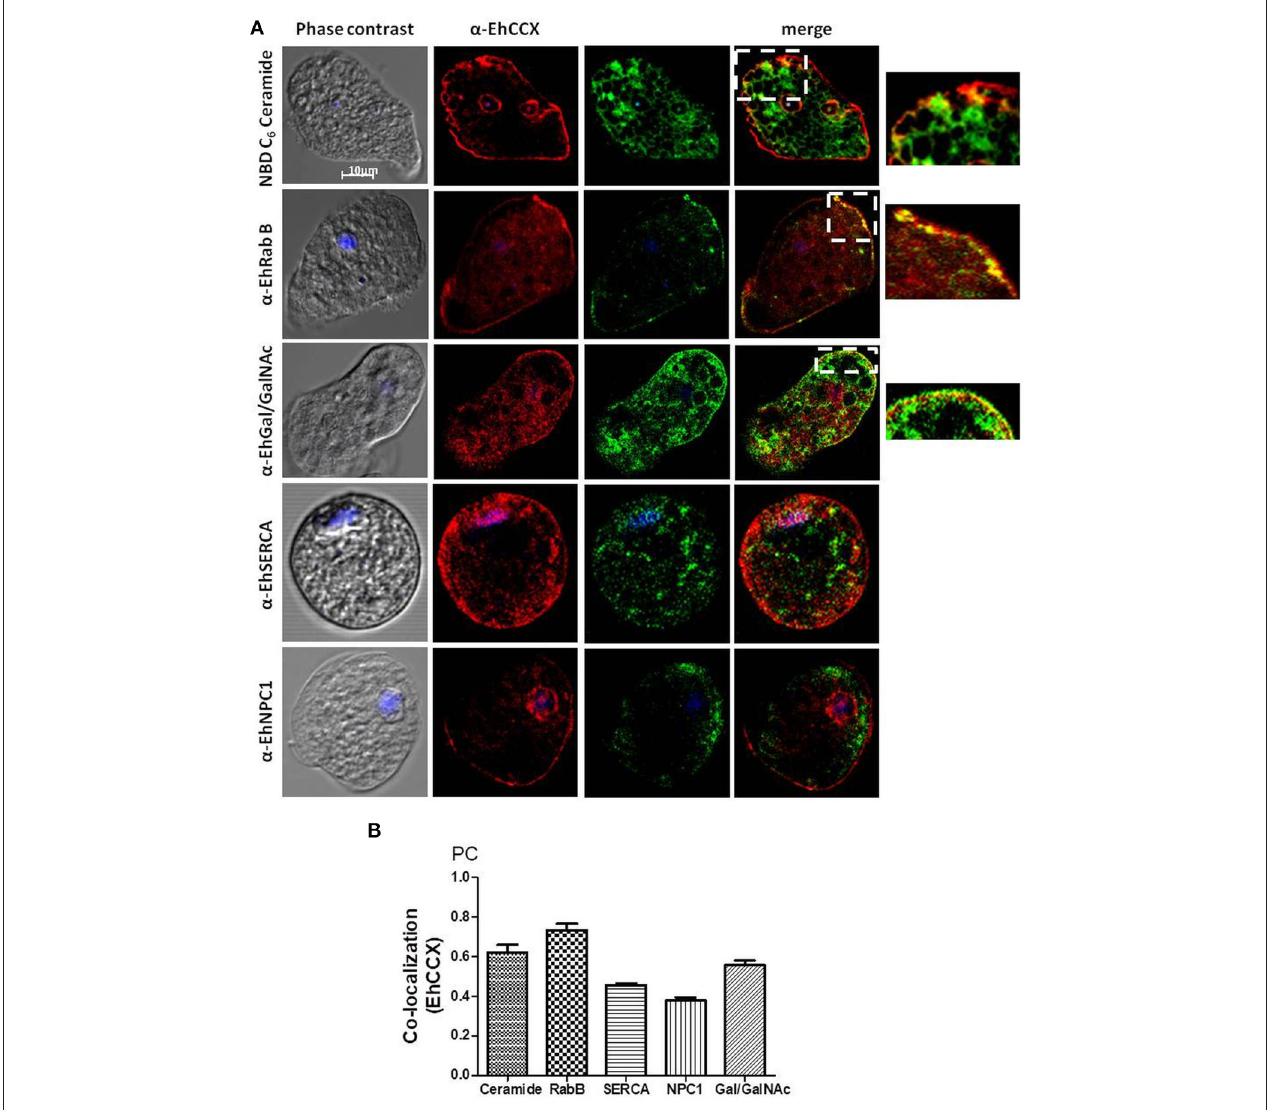
FIGURE 5 | Co-localization assays. (A) E. histolytica trophozoites were fixed, permeabilized and incubated with rat antibodies against EhCCX and subsequently with rabbit antibodies against EhSERCA, EhRabB, or EhNPC1, or mouse antibodies against the Gal/GalNac lectin. Afterwards, samples were incubated with anti-rat IgGs labeled with Alexa 555, and with anti-rabbit IgGs labeled with Alexa 488 or anti-mouse IgGs labeled with FITC. Alternatively, after incubation with α -EhCCX and the anti-rat secondary antibody, trophozoites were incubated with NBD C 6 -ceramide. Finally, nuclei were stained with DAPI and samples were analyzed by confocal microscopy. On the right are shown magnifications of the squares marked in the merge images of co-localization with NBD C 6 -ceramide, EhRabB, and Gal/GalNac lectin. (B) Pearson coefficients of co-localization between EhCCX and the different markers.